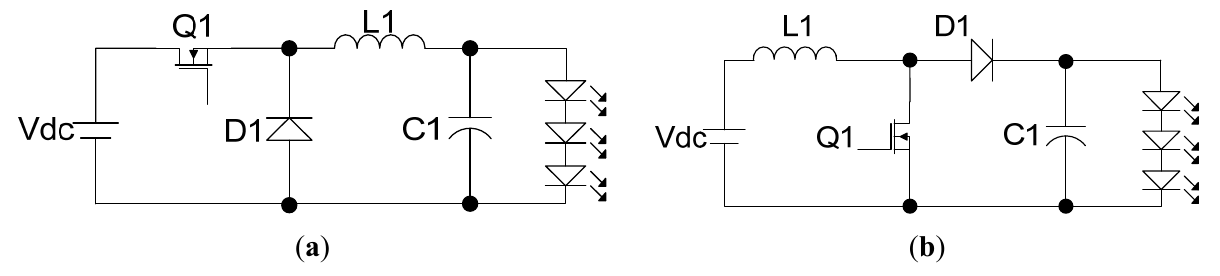
Figure 3. Buck and Boost converter for LED Application. ( a ) buck converter; ( b ) boost